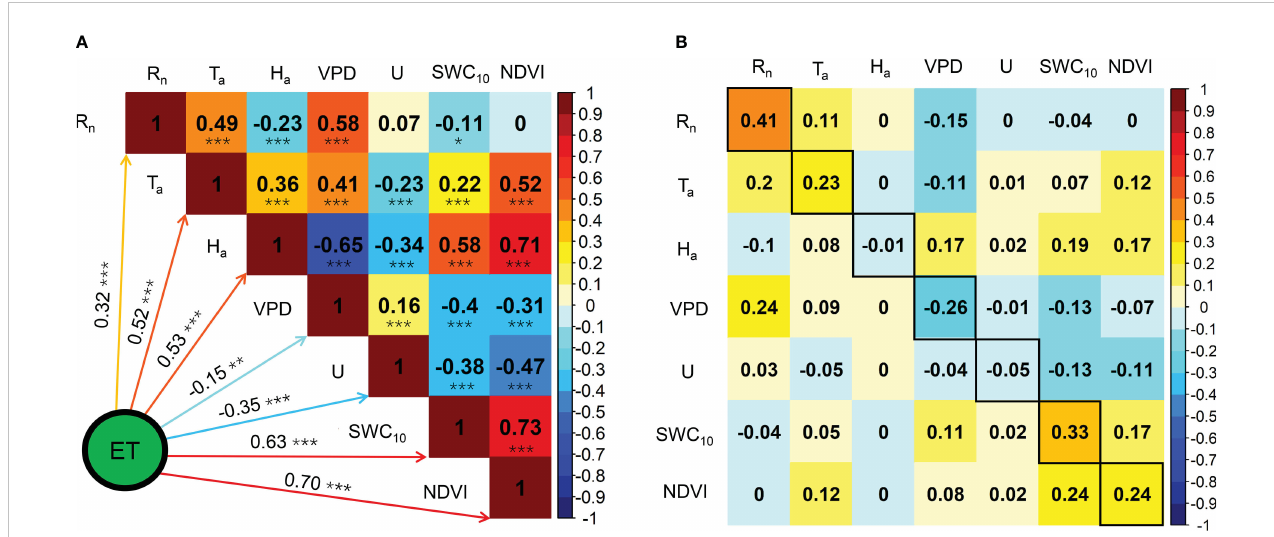
FIGURE 10 Correlation analysis (A) and path analysis (B) among daily ET and biophysical factors during the growing seasons in 2020 and 2021. * Signi fi cant at p< 0.05; ** signi fi cant at p< 0.01; *** signi fi cant at p<